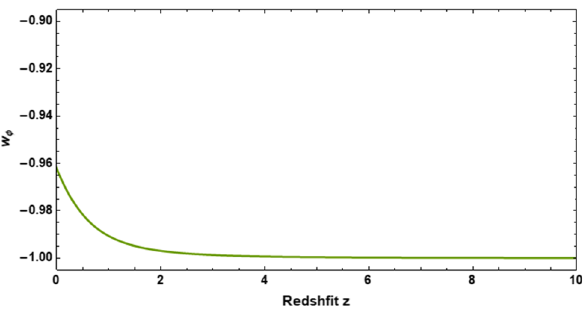
Fig. 2 The equation of state of the quintessence field w φ . When z = 0, w φ ≈ − 0 . 96